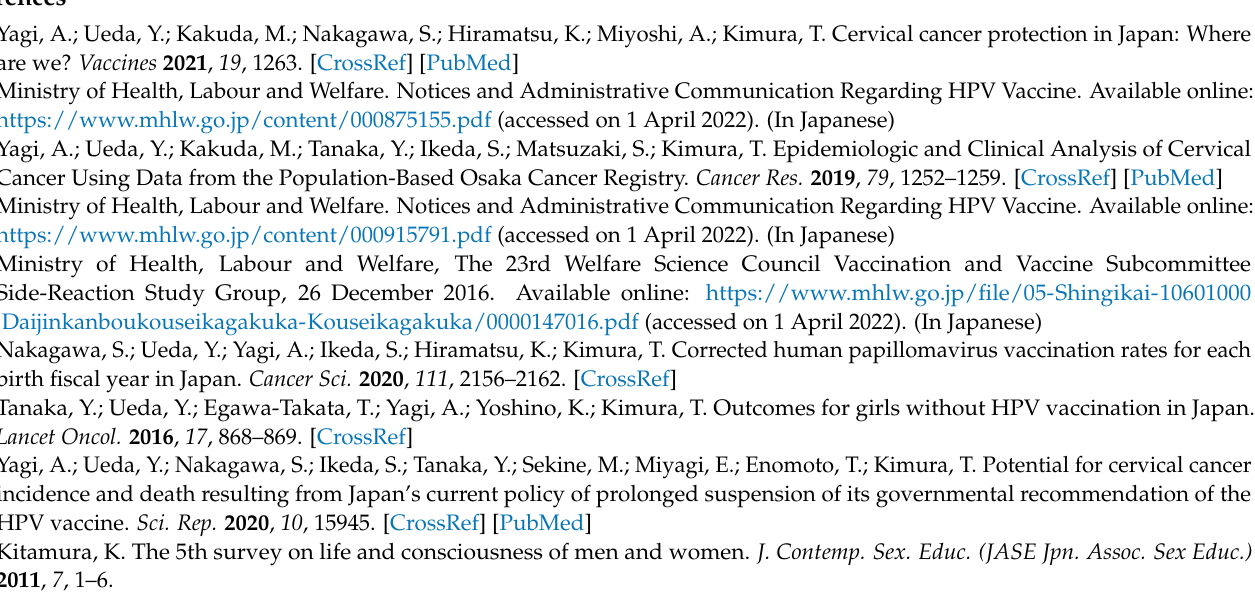
Table S3: Estimated number of HPV vaccine doses required based on HPV vaccination